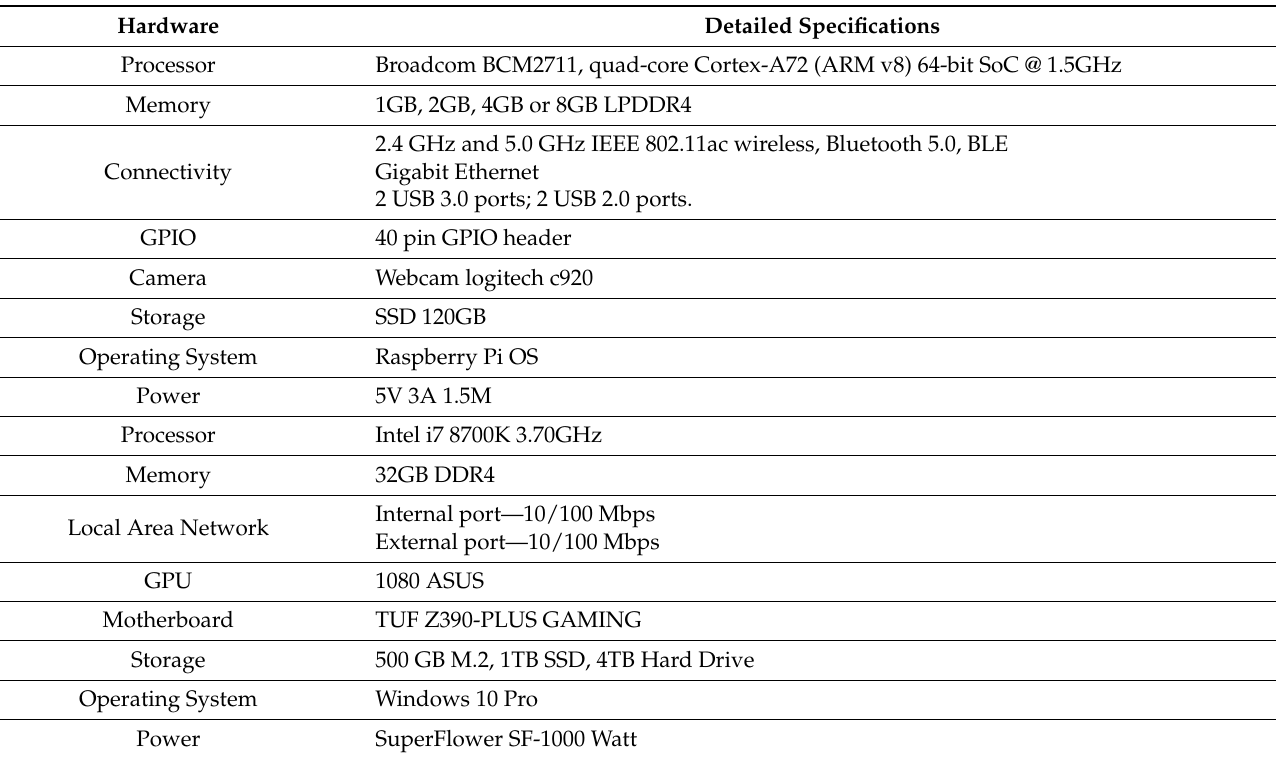
Table 2. Raspberry Pi 4 Model B specifications and Windows Desktop